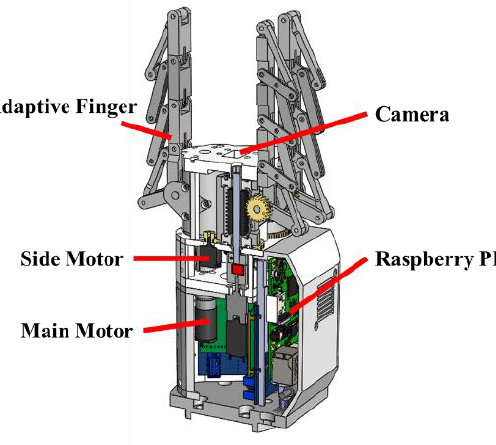
Figure 3. Section view of the model gripper.